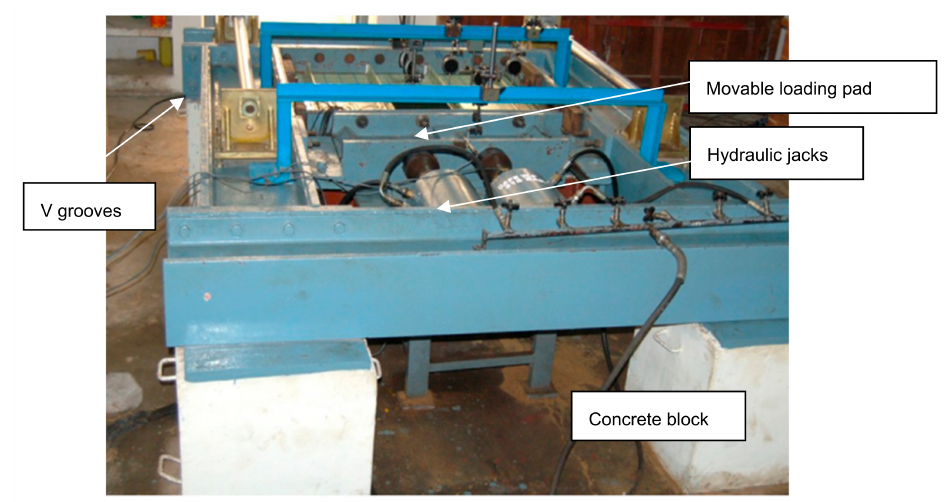
Figure 8. Test facility.